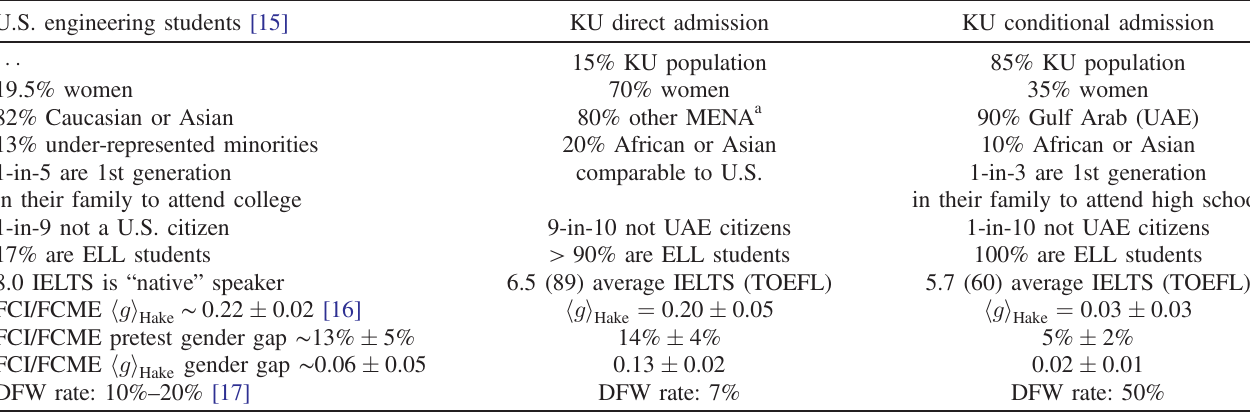
TABLE I. Salient demographic and learning gains data, comparing U.S. and KU engineering student populations taking traditional, calculus-based introductory